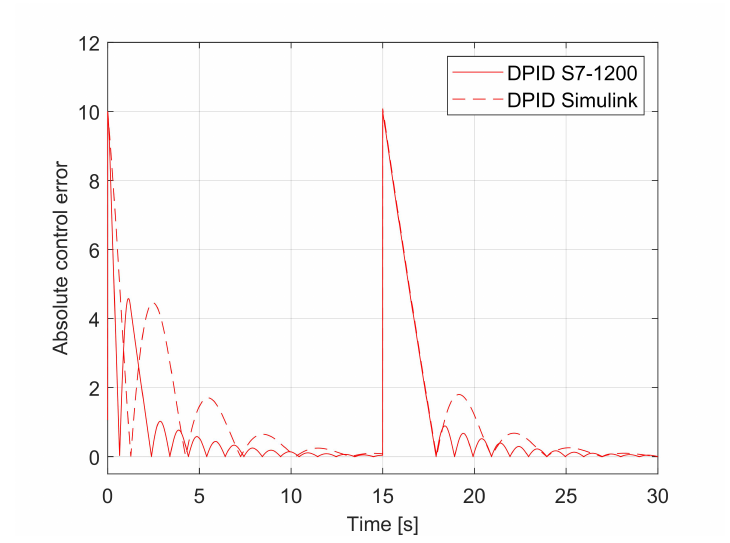
Figure 5. Abs.control errors of DPID closed-loop realizations’ responses.